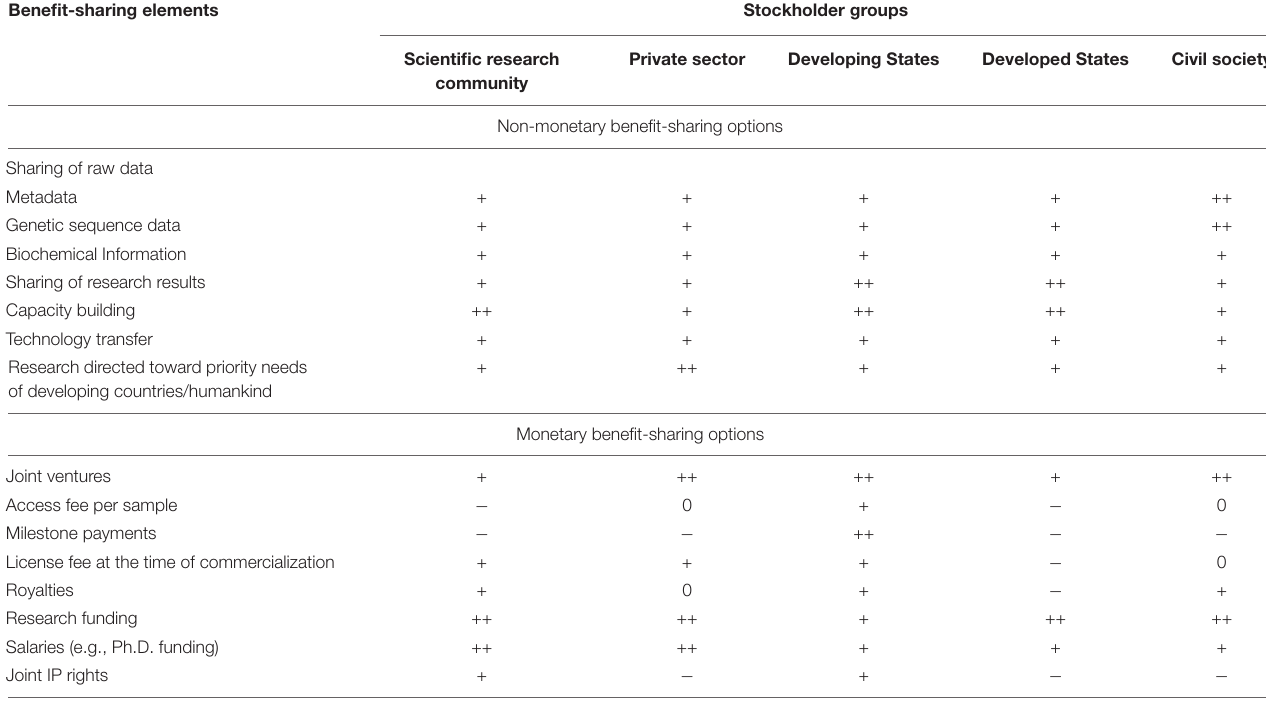
TABLE 4 | Stakeholder perspectives on non-monetary and monetary benefit-sharing options in the context of MGR from